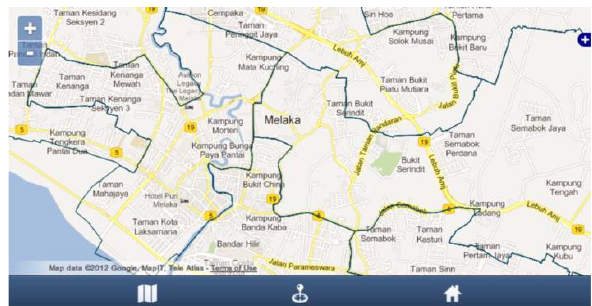
Figure 11. The Dun Melaka after Applying Datum Transformation